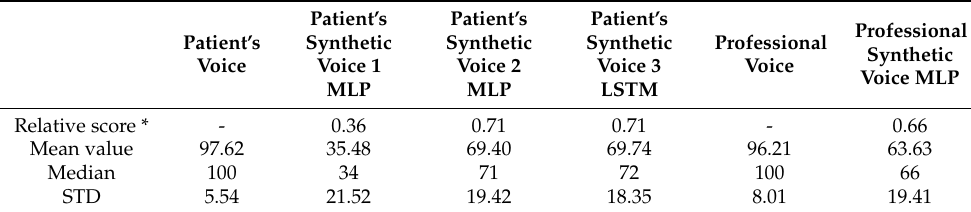
Table 1. MUSHRA test results.